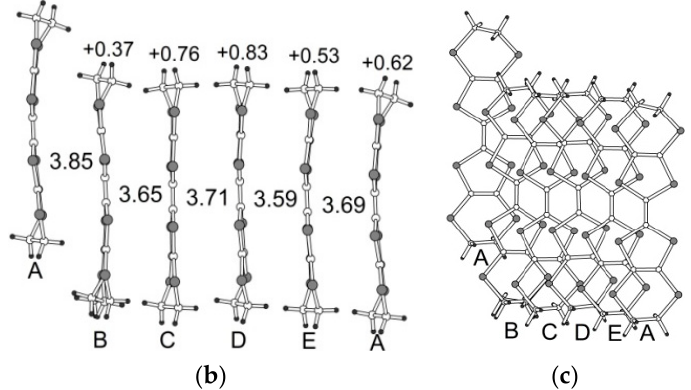
Figure 6. ( a ) View of the radical cation layer of α″ -type in 5 along the long molecular axis. Short S···S contacts < 3.6 Å are shown by dashed lines; ( b ) side view of the stack with interplanar separations (in Å) and calculated charges of BEDT-TTF; and ( c ) overlap modes within the stack. The anion layer in 5 consists of [Ga(ox) 3 ] 3 − anions interacting by hydrogen bonding through water molecules (Figure 7).